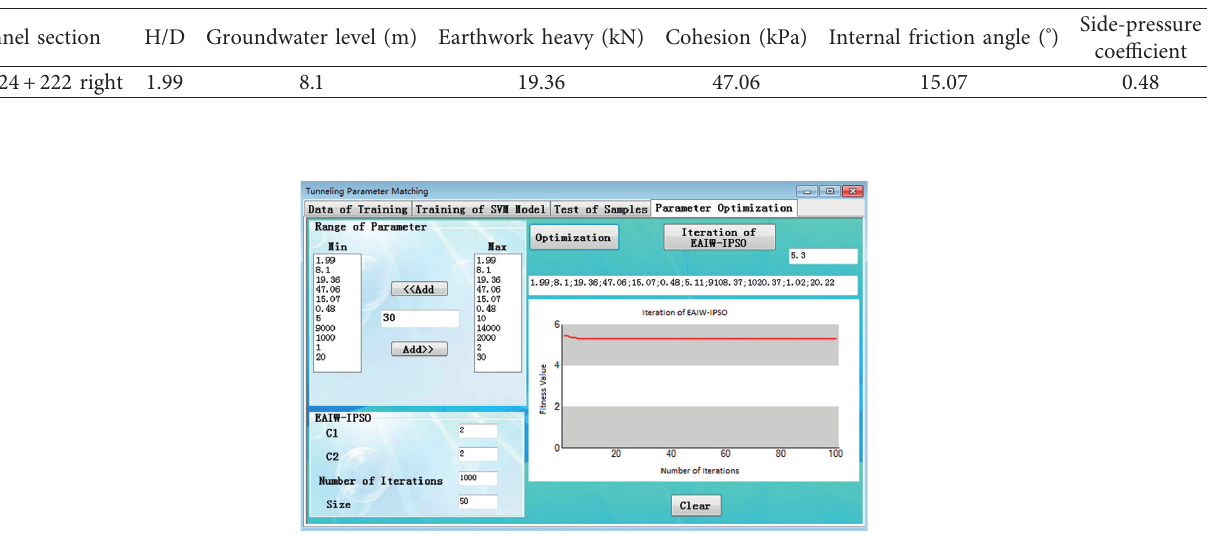
Table 4: Geometric and formation condition parameter values.